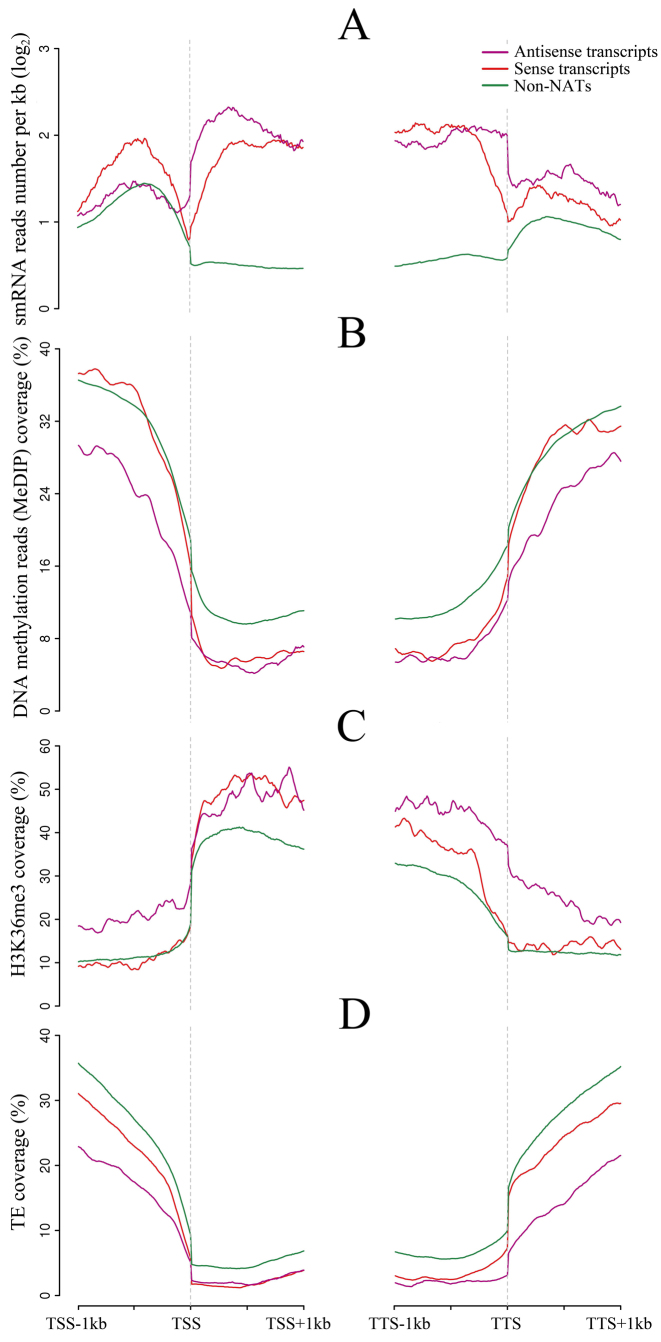
(A-D) The degree of enrichment of smRNAs, DNA methylation, H3K36me3 and TEs. The average enrichment levels are plotted with respect to transcription start sites (TSS) and transcription termination sites (TTS). The figure legend is in the top right corner. On the x-axis, kilobytes from the start and end of transcription are shown. In the y-axis, the number of reads was averaged in a 100 bp sliding window moving in 10 bp increments.